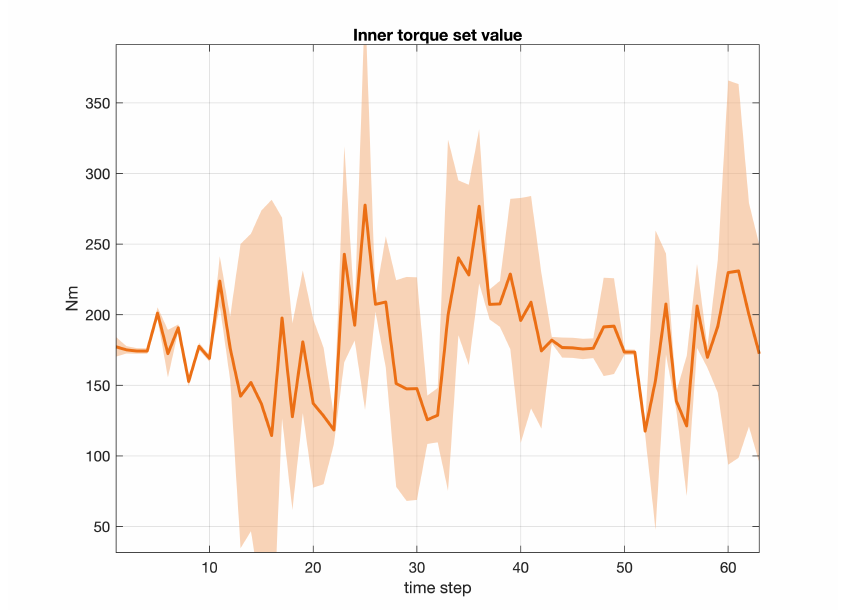
Figure 8. Inner torque set value (label 12). Average value (continued bold line) and 3-sigma area plot for 203